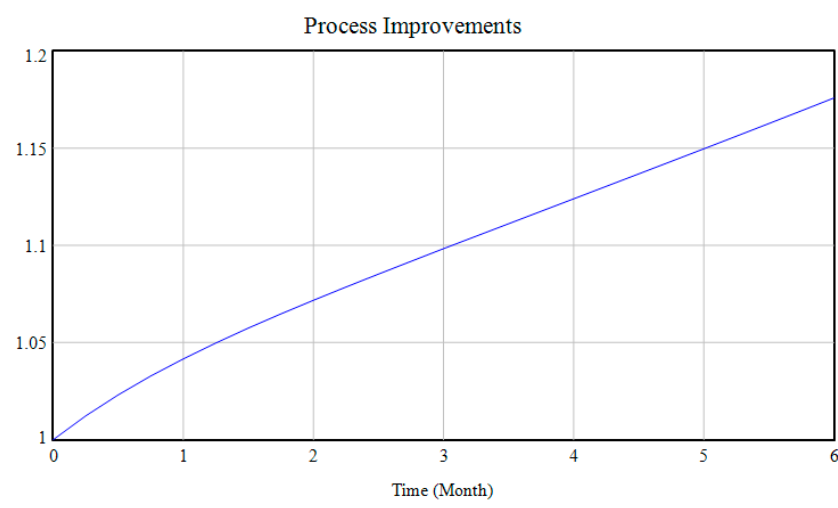
Figure 16. Simulation result of ‘process improvements’.